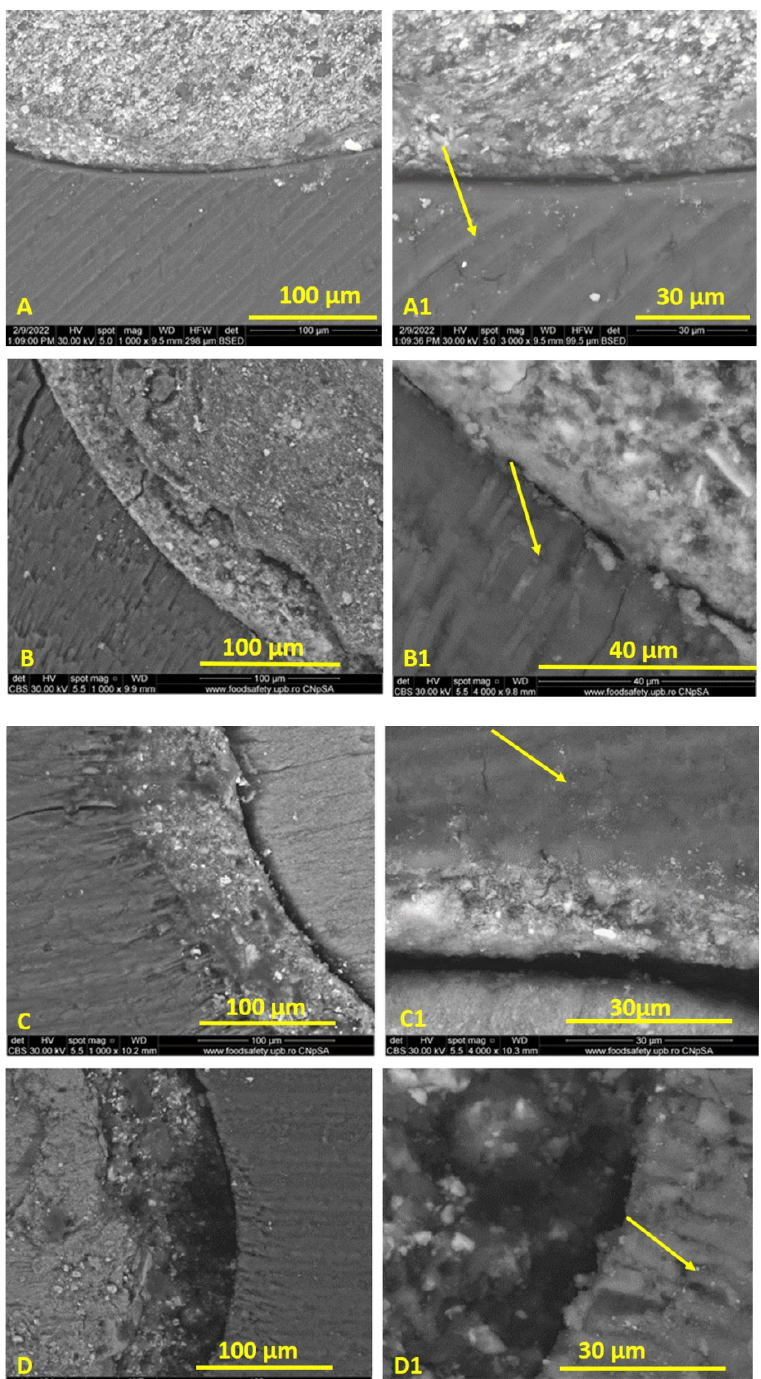
Figure 6. Representative images of interfacial failure and dentine tubule penetration for tested endodontic sealers. RSSE—adhesive failure ( A , A1 ); EBCS — cohesive failure ( B , B1 ); EDS—cohesive endodontic sealers. RSSE—adhesive failure ( A , A1 ); EBCS—cohesive failure ( B , B1 ); EDS—cohesive failure ( C , C1 ); BRS—adhesive failure ( D , D1 ). failure ( C , C1 ); BRS—adhesive failure ( D , D1